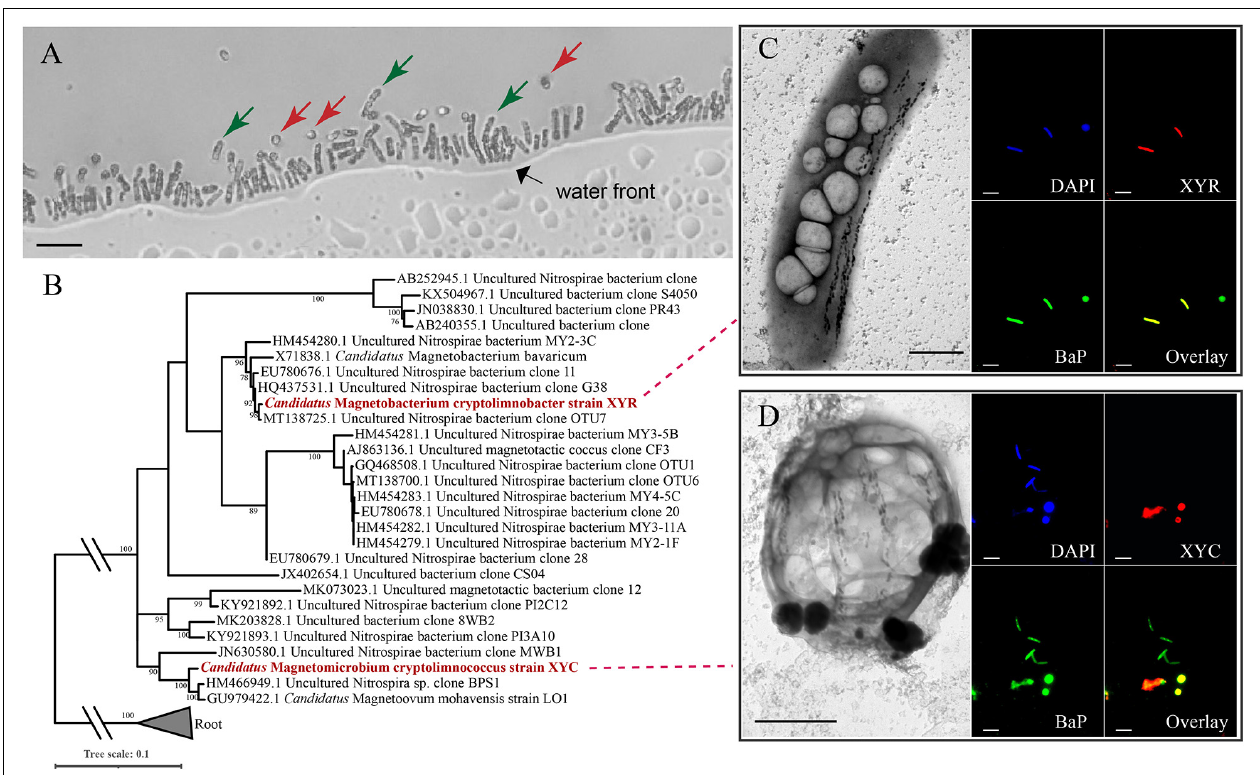
FIGURE 1 | Phylogenetic and morphological identification of two novel Nitrospirae MTB. (A) Morphologies of Ca . Magnetobacterium cryptolimnobacter strain XYR cells (green arrows) and Ca . Magnetomicrobium cryptolimnococcus strain XYC cells (red arrows) as revealed by light microscopy (bar = 10 µ m). (B) Phylogenetic tree based on comparative sequence analysis of 16S rRNA genes. Numbers at nodes are bootstrap support values ( n = 1,000, only bootstrap values greater than 75% are shown). (C,D) Transmission electron microscopy pictures (bar = 1 µ m) and fluorescence in situ hybridization results (bar = 10 µ m) of cells of XYR and XYC, respectively. BaP is the probe specific for most Nitrospirae MTB (Spring et al., 1993; Lin et al., 2011).